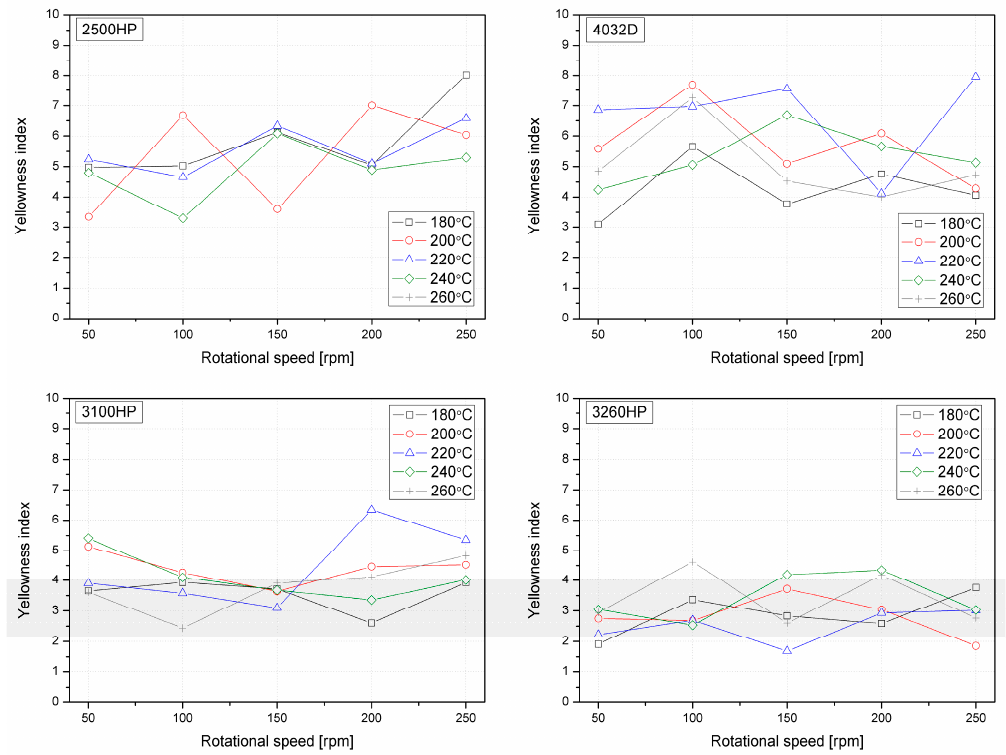
Figure 5. The yellowness index (YI) of PLAs processed with various processing parameters.